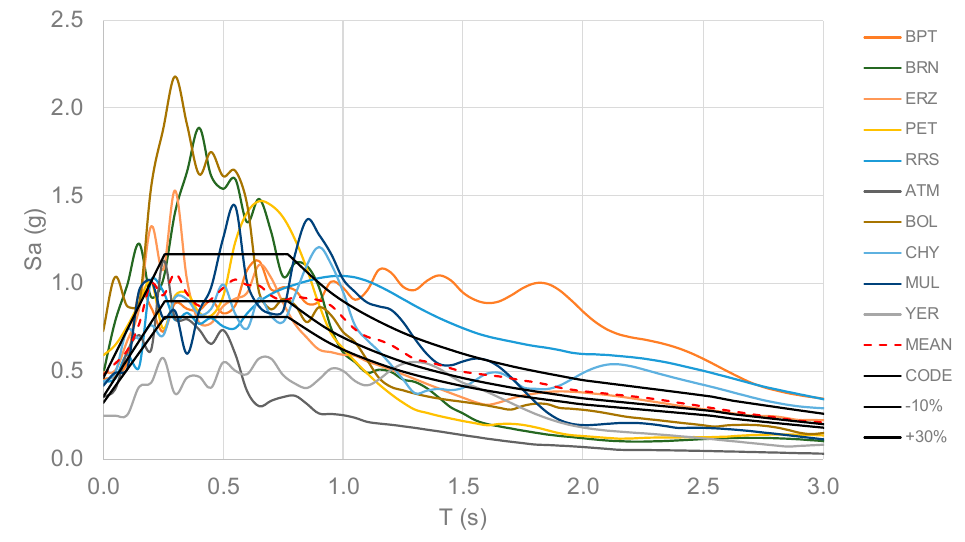
Figure 10. Selected input motions. Table 7. Input motion characteristics.